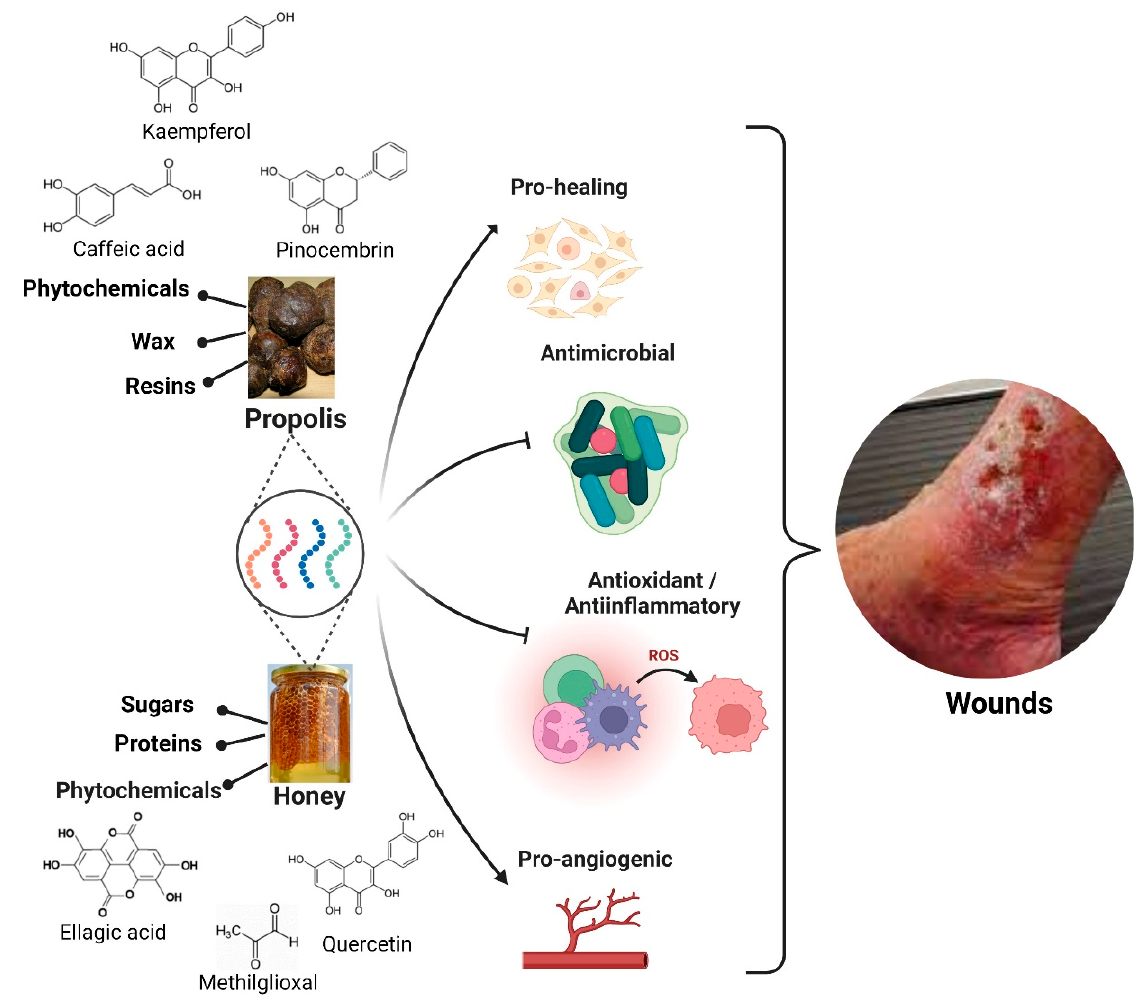
Figure 3. Properties of honey and propolis described for wound healing applications [6,39,40]. Created with BioRender.com.